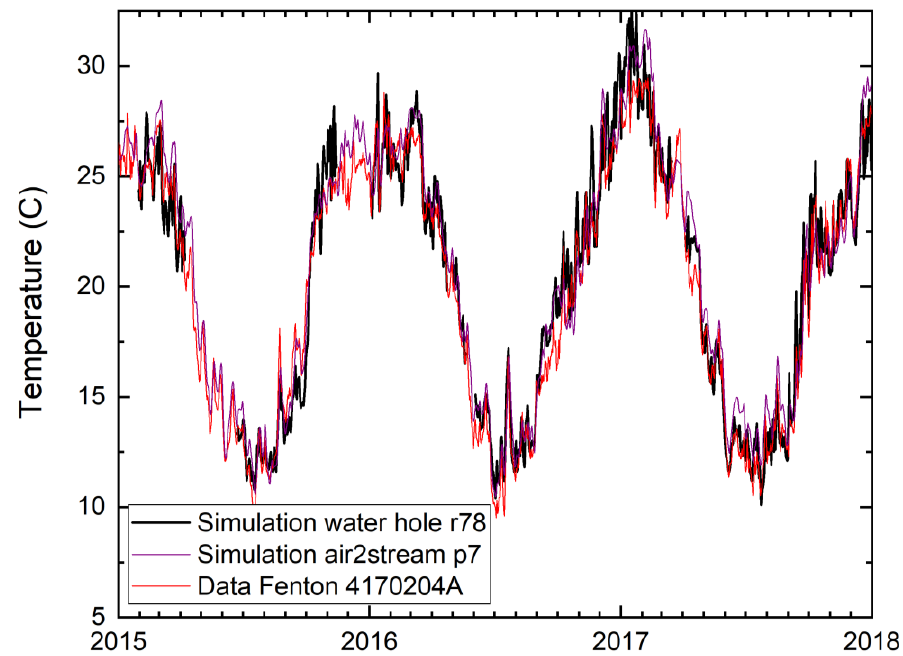
Figure 5. Comparison between observed water temperature (Station 4170204A at Fenton, Moonie) and simulated water temperatures for this location using the air2stream model with p = 7 parameters [67] (purple), and the LAKEoneD lake temperature model for water hole r78 (black).